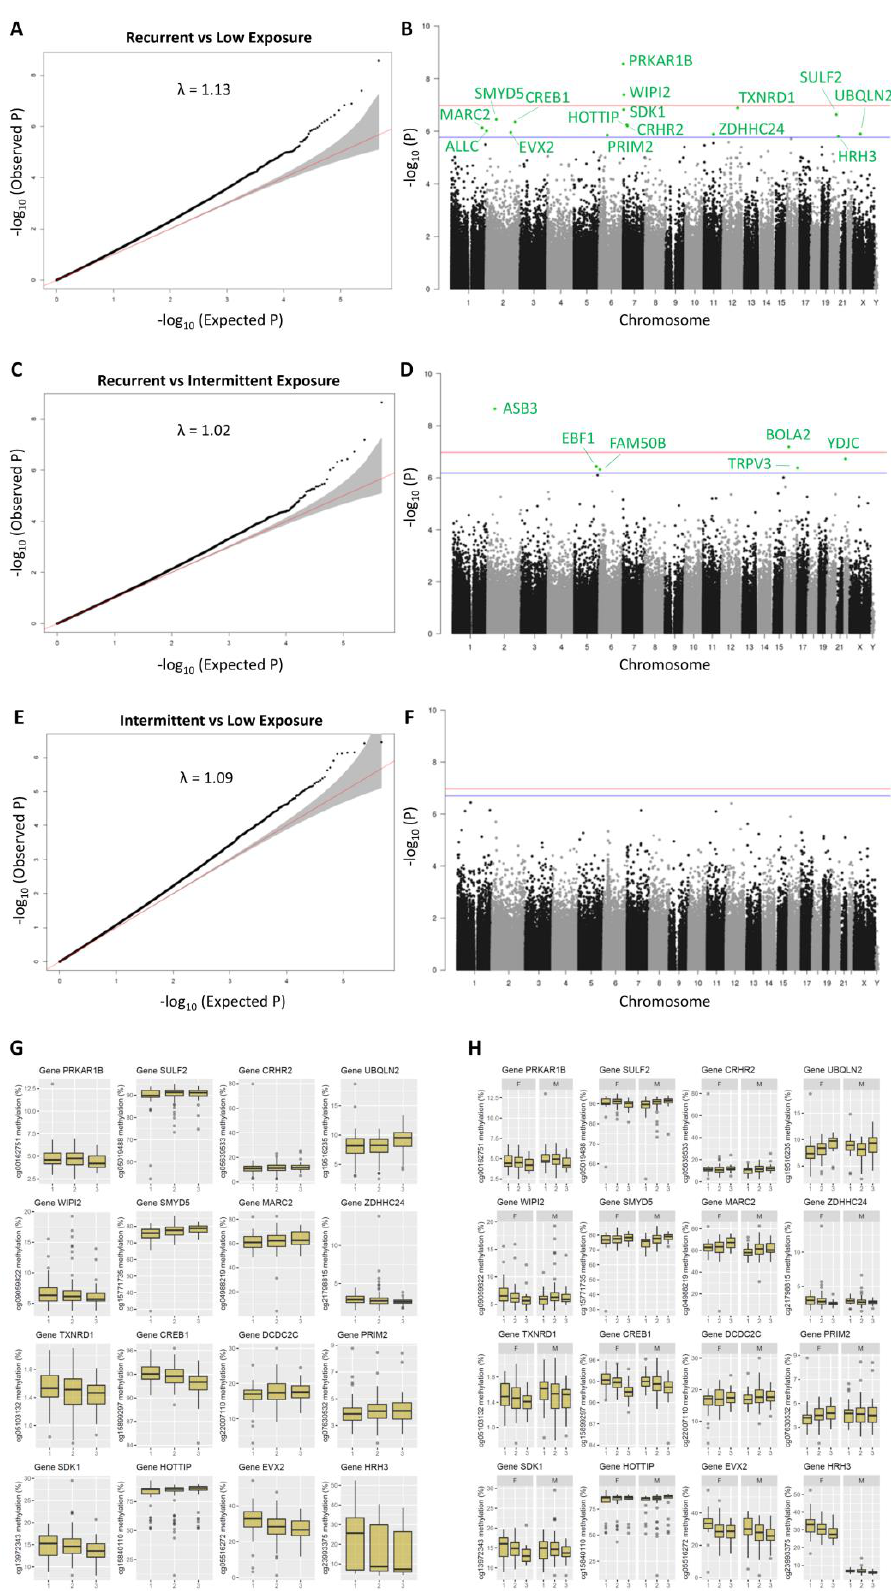
Figure 3. Categorical time-dose DMP analysis (recurrent, intermittent or low exposure) of aflatoxin levels over the period of 6, 12 and 18 months postnatally. ( A , C , E ) Q-Q plots and the genomic